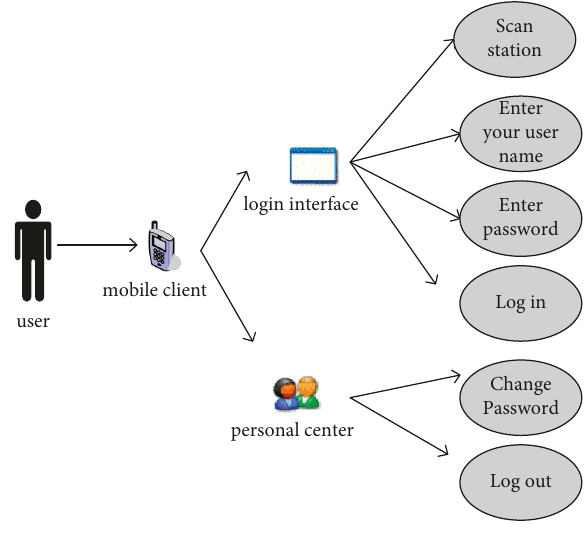
Figure 2: User management use case diagram. Table 1: User management use case